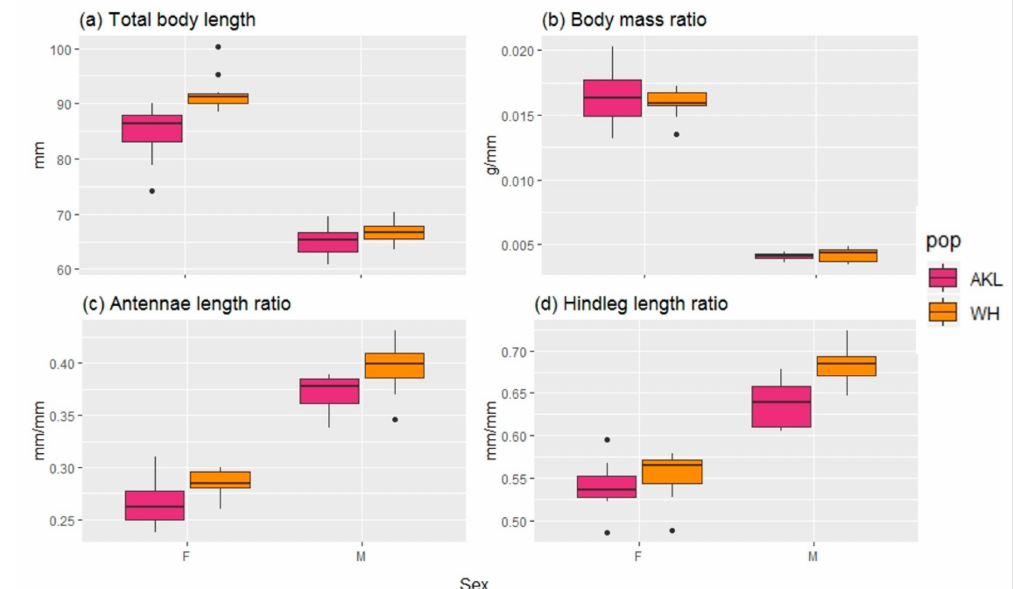
Figure 4. Box-and-whisker plots showing a comparison of the morphological traits of male (M) and female (F) Clitarchus hookeri from two sexual populations (pop) in New Zealand (AKL = Auckland, WH = Whanganui). The ends of each box represent the upper and lower quartiles, the median is marked by the vertical line inside the box. The whiskers show the highest and lowest observations, and the black points indicate outliers. Table 2. Male and female Clitarchus hookeri stick insects from two New Zealand sexual populations (AKL = Auckland, WH = Whanganui) di ff er in body shape and chemical volatiles as resolved by the Friedman test and pairwise Mann–Whitney comparisons. Total body length (BL), body mass ratio (BM), antennae length ratio (A), hind leg length ratio (HL), and monoterpenes (M) emitted